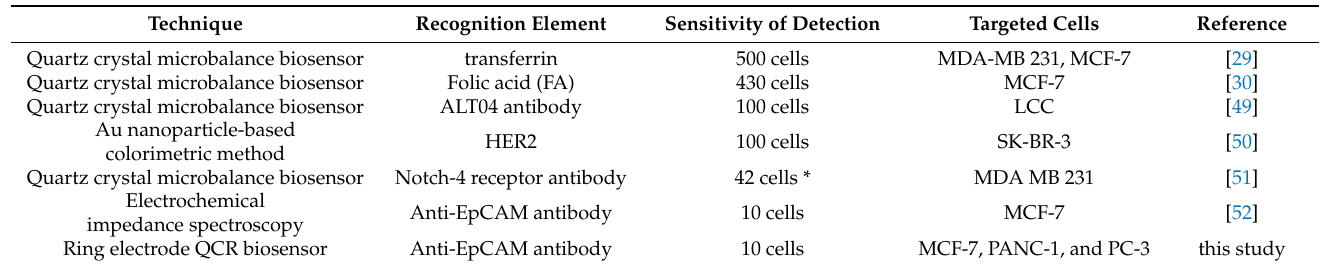
Table 3. Table comparing the detection efficiency of various techniques, including quartz crystal- based sensors, with our